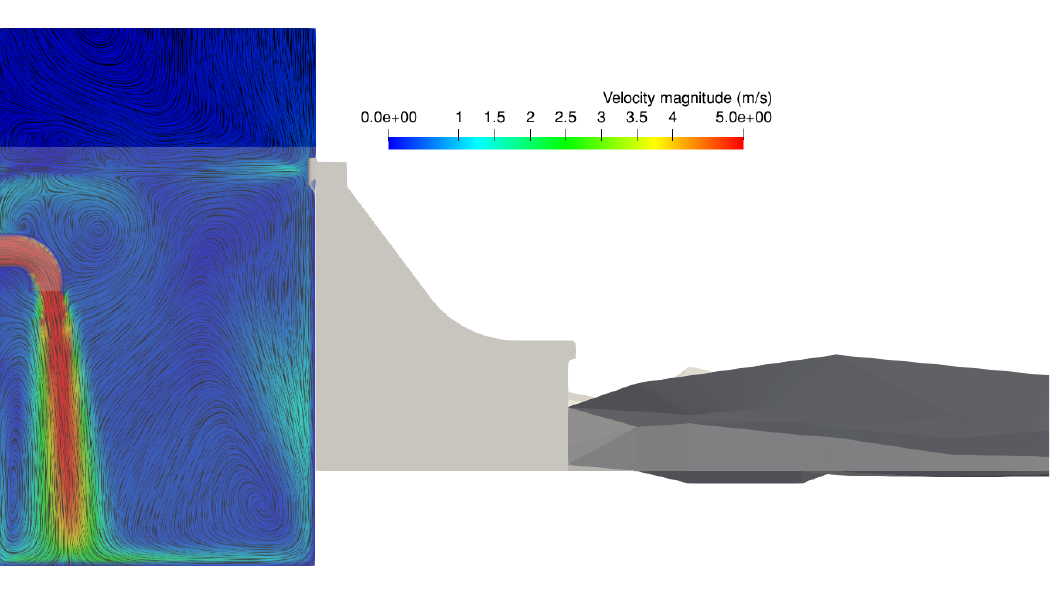
Figure 3. Geometry model of the configuration with the downstream dam (the downstream dam is highlighted in red and the profile shown in the detail). The light blue transparent region denotes the simulation domain.